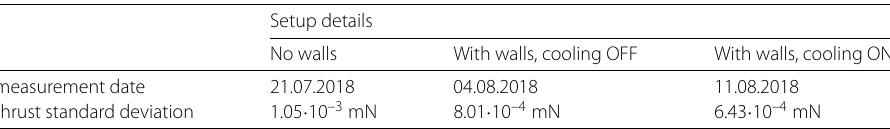
Table 4 Impact of cooled DEPB sidewalls Setup details No walls With walls, cooling OFF With walls, cooling